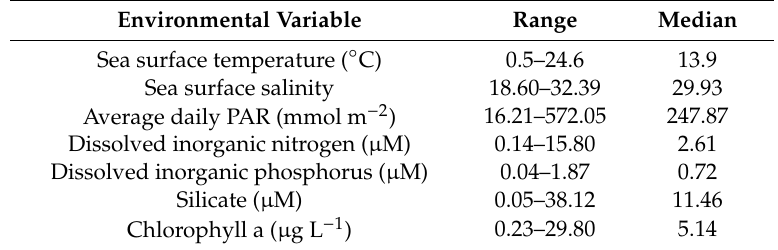
Table 2. Range and median of environmental variables across the 80 field samples (2008–2014).